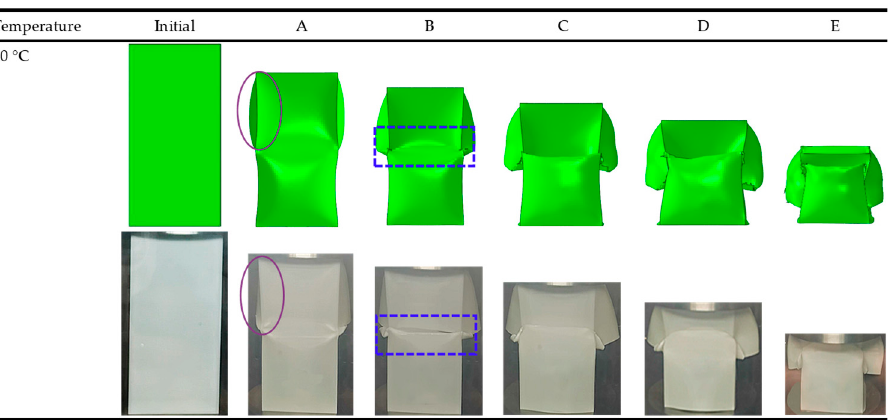
Figure 7. At 40 °C , the experimental and simulation comparison results of the deformation modes of CST.